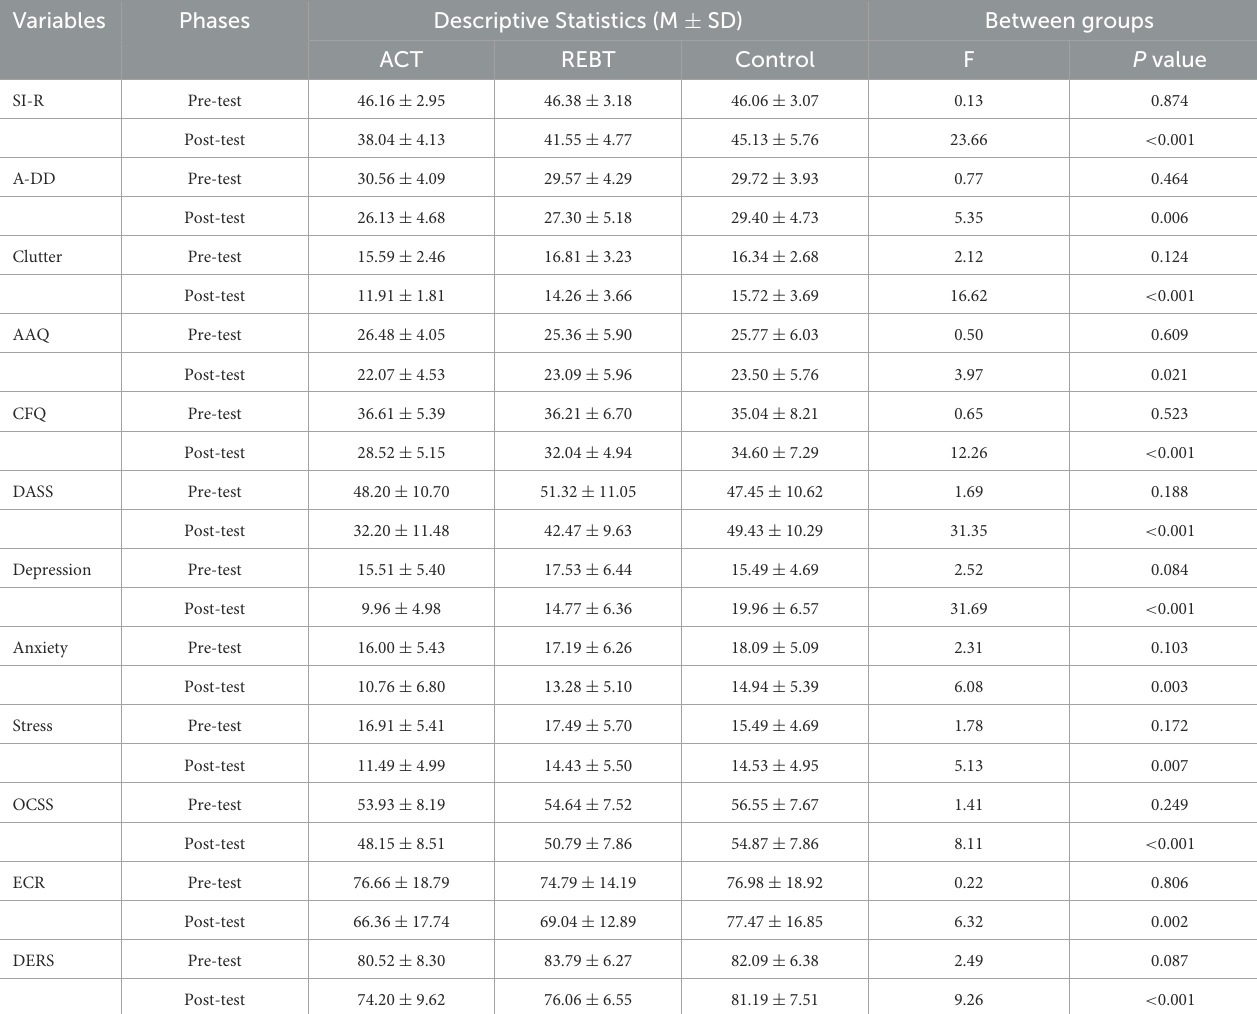
TABLE 3 Descriptive statistics and one-way